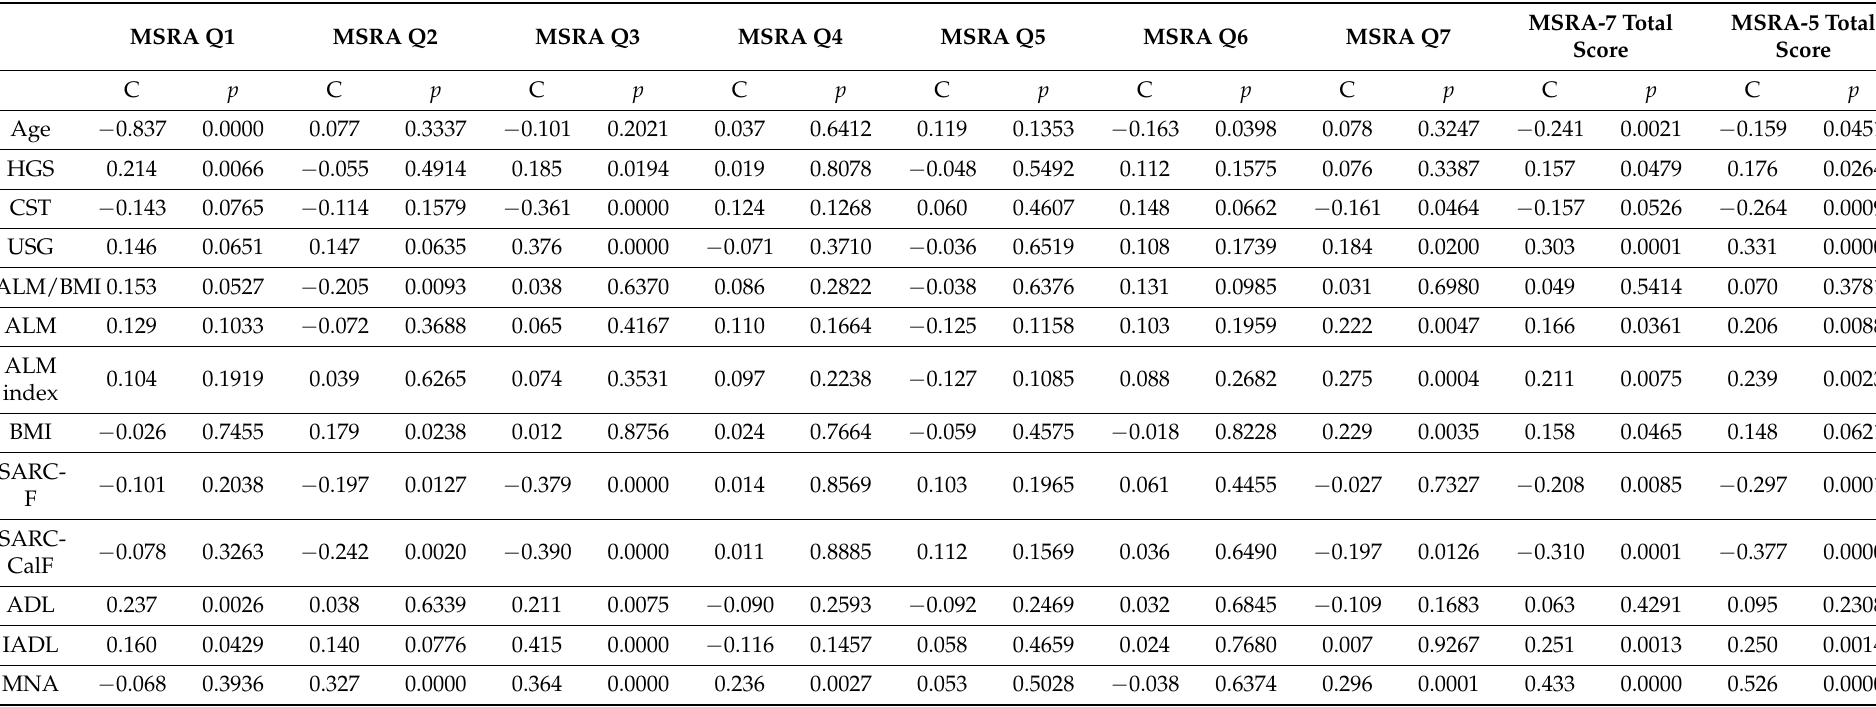
Table 7. Validation between the PL-MSRA-7 and PL-MSRA-5 (each domain and total score) and other related